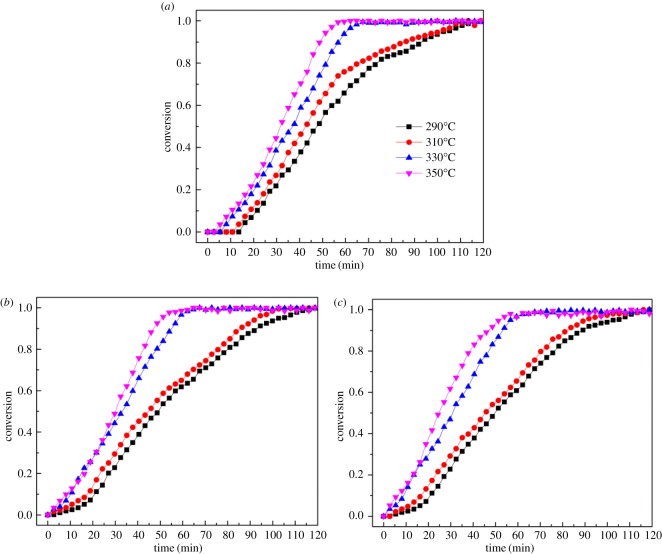
The conversion of oxidation in air atmosphere for the (a) YBaCo4O7+δ, (b) Y0.95Ti0.05BaCo4O7+δ and (c) Y0.5Dy0.5BaCo4O7+δ samples.